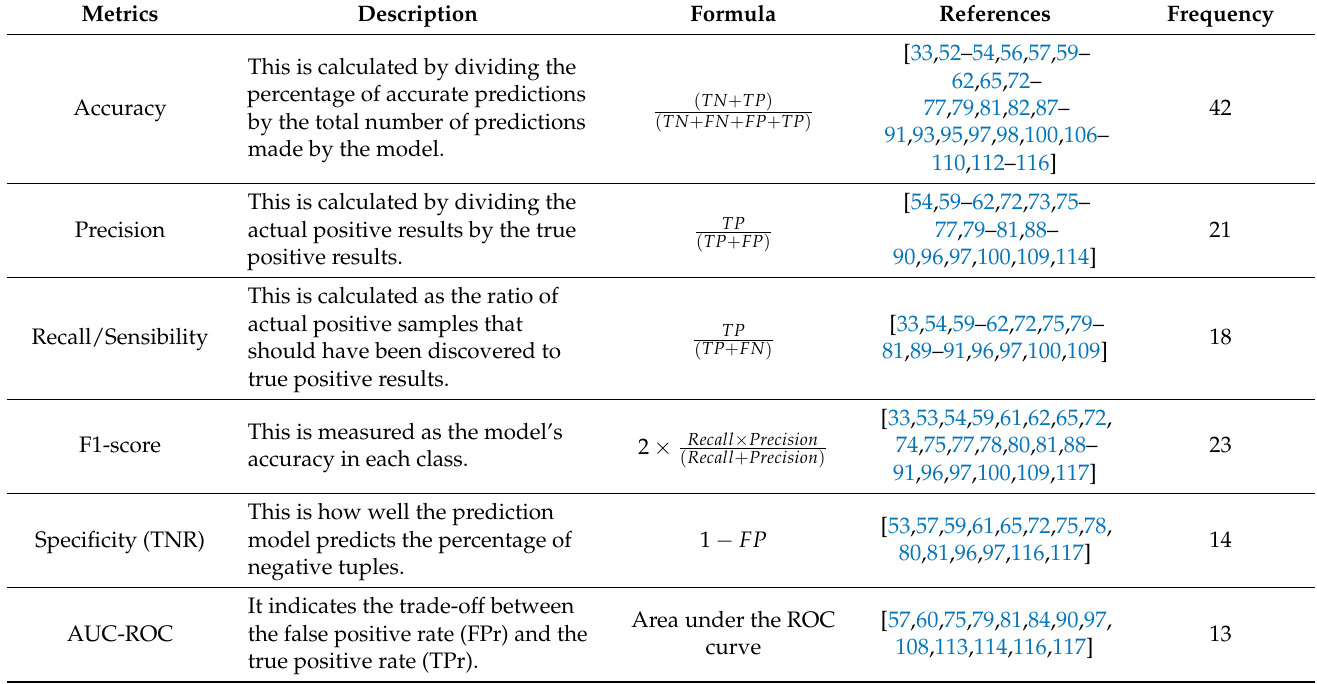
Table 6. Performance evaluation